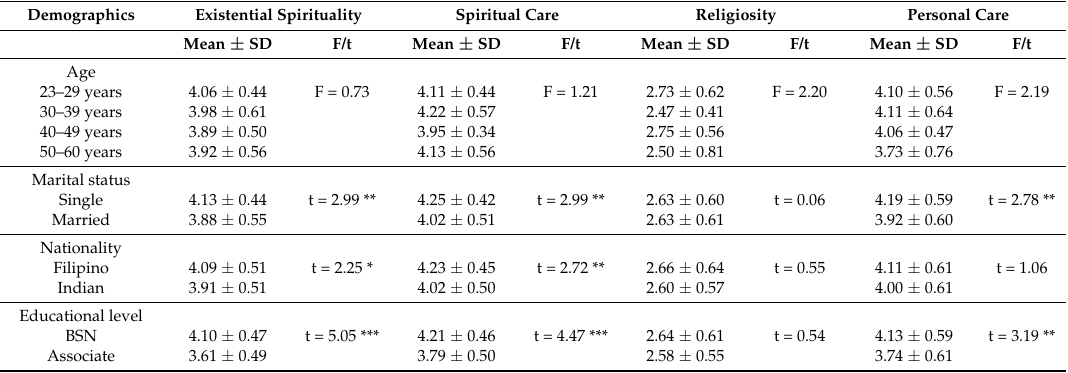
Table 2 reflects the perceptions on spirituality and spiritual care of the respondents. As indicated, the spiritual care dimension received an overall mean score of 4.13 (SD = 0.49), whereas personal care and existential spirituality received mean scores of 4.05 (SD = 0.61) and 4.00 (SD = 0.51), respectively. The respondents reported poor perceived religiosity, as indicated by a mean score of 2.63 (SD = 0.60). Table 2. Spirituality and Spiritual Care Rating Scale (SSCRS) mean subscale scores and their association with the demographic characteristics ( n =